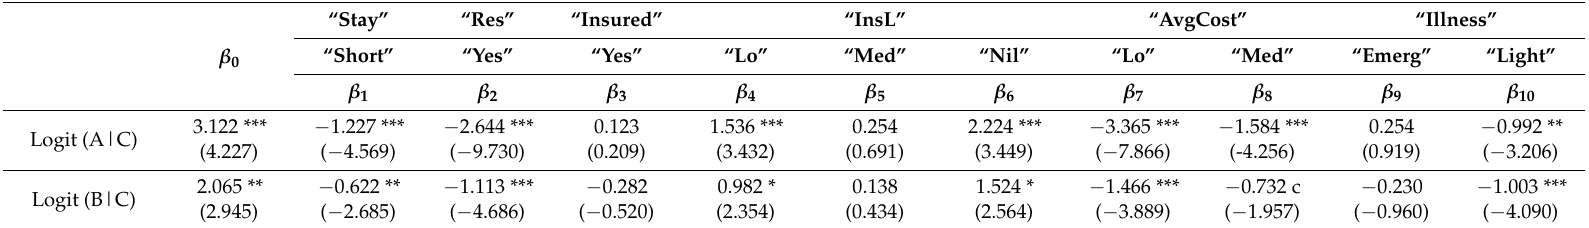
Table 10. Estimation